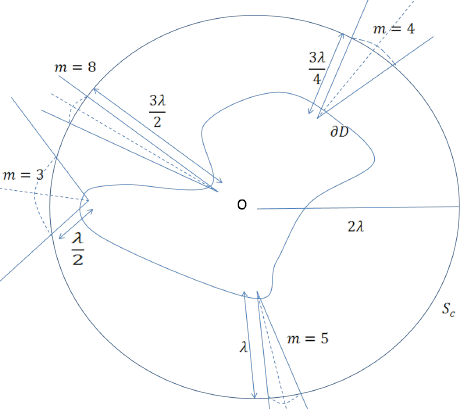
= e m λ . For several parameters m , the taller 2 π k